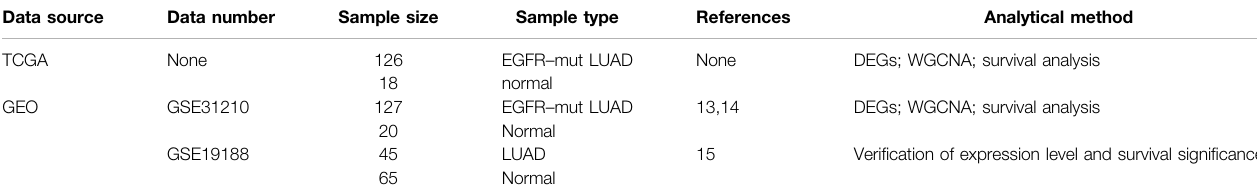
TABLE 1 | Research usage data